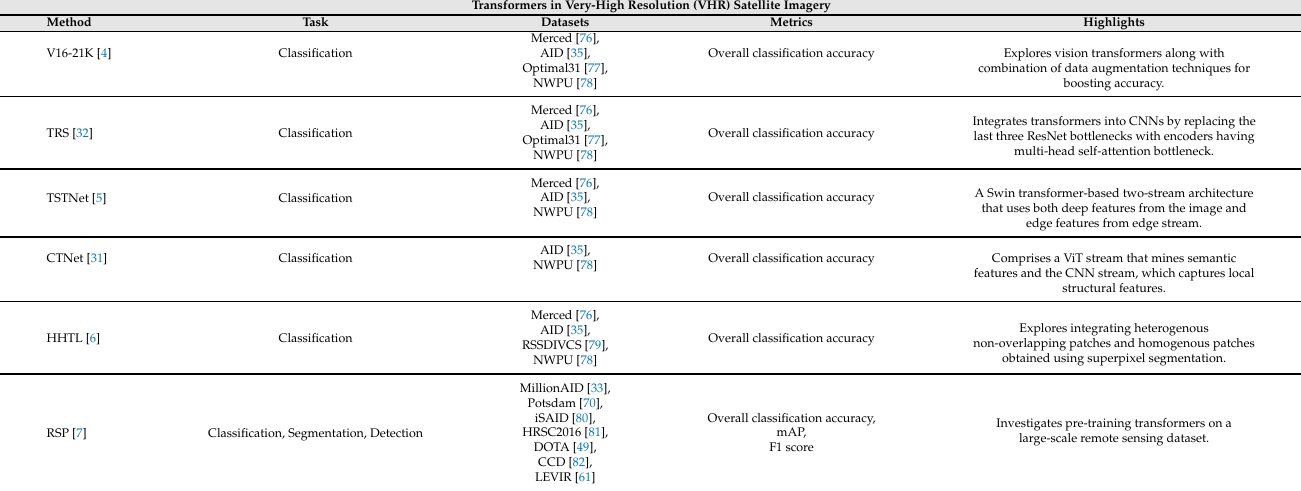
Table 5. Overview of transformer-based approaches in VHR remote sensing imaging. Here, we highlight transformer-based methods for different VHR remote sensing